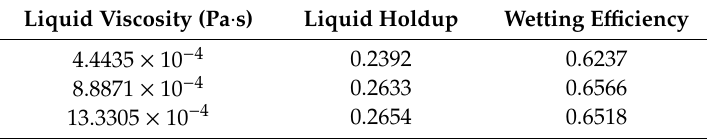
Table 7. Liquid holdup and wetting efficiency of three liquid viscosities.